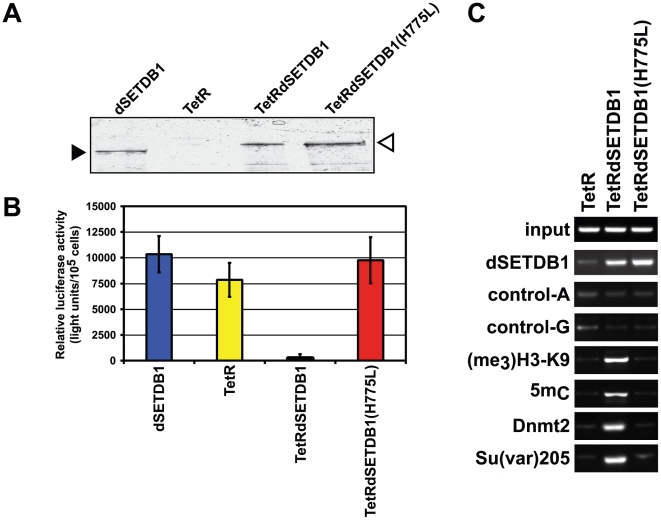
Methylation of H3-K9 by dSETDB1 mediates transcriptional silencing.(A) Western blot analysis detecting dSETDB1 (black triangle) and tetracycline repressor (TetR)–SETDB1 (TetRSETDB1) fusion proteins (open triangle) in S2 cells transiently expressing dSETDB1, TetR, or fusion proteins of TetR with dSETDB1 or dSETDB1(H775L). Forty-eight hours after transfection, total cell extracts were prepared, separated by SDS-PAGE, and electrophoretically transferred onto nitrocellulose membrane for probing with antibody to dSETDB1. (B) Schematic representation of luciferase assays with whole-cell extracts prepared from cells described in (A). The tetO-tk-luc reporter gene contains tet operator (tetO) sequences, which are fused to the human thymidine kinase (tk) promoter driving the expression of luciferase (luc). The diagram shows the mean values calculated from data from 5 different experiments. Error bars indicate the standard error of the mean (SEM). (C) Digital images of ethidium bromide-stained agarose gels showing the reaction products of PCR assays monitoring the presence of the promoter region of the tetO-tk-luc reporter gene in DNA pools obtained by chromatin immunoprecipitation (ChIP). Chromatin was isolated from (tetO-tk-luc)-S2 cells expressing TetR, TetRdSETDB1, or TetRdSETDB1(H775L) and immunoprecipitated with antibodies to dSETDB1, Su(var)205, Dnmt2, (me3)H3-K9, and methylated cytosine (5mC), or protein-A agarose (control-A) and protein-G agarose (control-G). Input indicates the amount of target DNA present in 1% of the input chromatin.